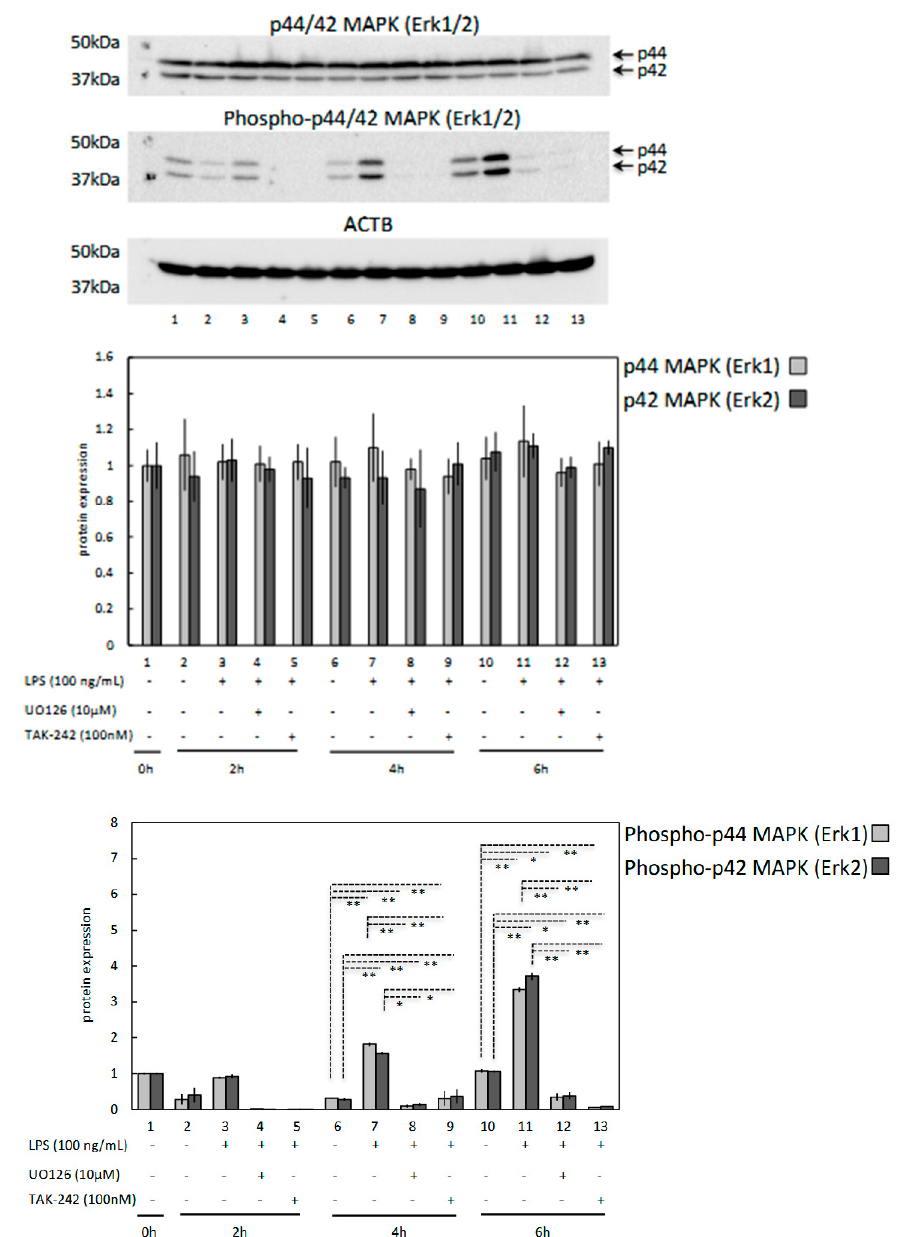
Figure 7. Effects of LPS treatment and MAPK (UO126, 10 µ M) and TLR4 (TAK-242, 100 nM) inhibitors on protein expression of p44/42 MAPK (Erk1/2) and phosphorylated p44/42 MAPK (Erk1/2) pro- teins for 0–6 h. ACTB expression (45 kDa) was used as a loading control. Representative immunoblots are shown. Lower panels represent densitometric values (standardized optical density; SOD) for Erk1 (p44), Erk2 (p42) and pErk1 (p44), pErk2 (p42) expression normalized against ACTB. A paramet- ric one-way ANOVA was applied followed by the Tukey–Kramer multiple comparisons post-test. All numerical data are presented as the means ± S.D. p -values < 0.05 were considered significant: * indicates p < 0.01, ** indicates p < 0.001. The original western blotting figures in Figure 7 can be found in Figure